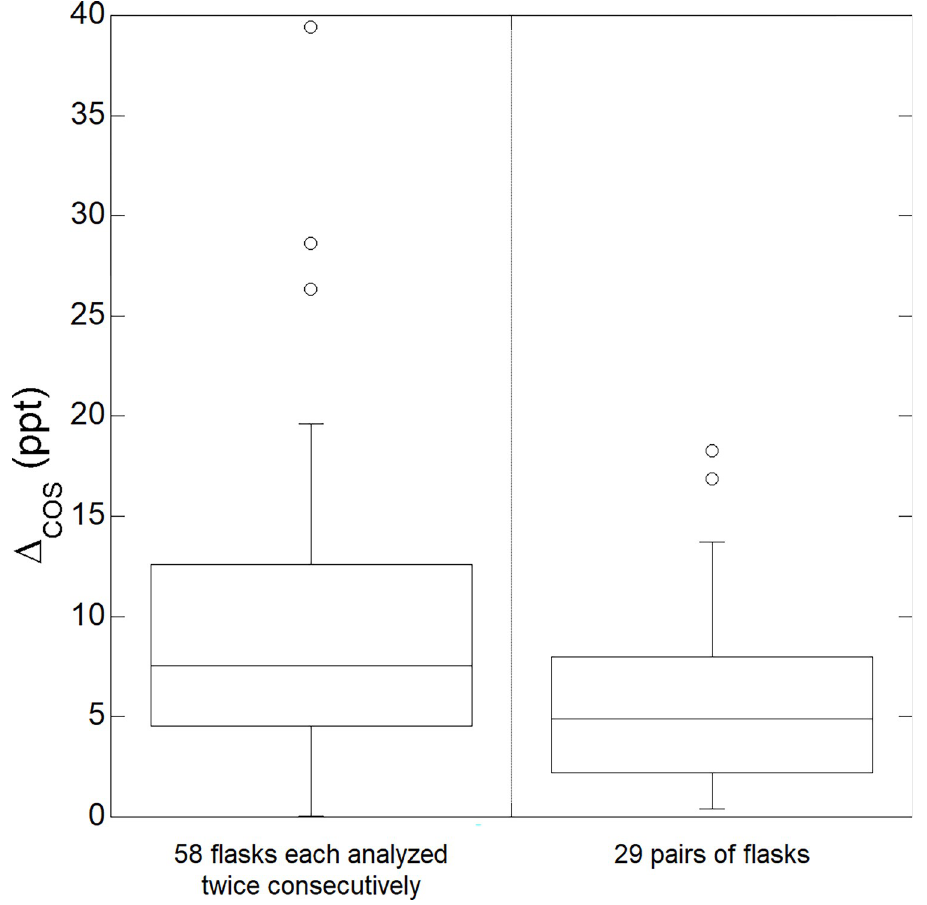
Fig 2. Analysis precision for COS measurements from flask-air samples collected upwind and downwind of selected crops. Left box plot: difference in COS (ppt dry air) between two consecutive analyses of each flask content (n = 58). Right box plot: difference in COS (ppt dry air) between flasks of the same pair (n = 29). Shown are10th, 25th, median, 75th and 90th percentile. Circles correspond to outliers. The study period extends from late March to late July